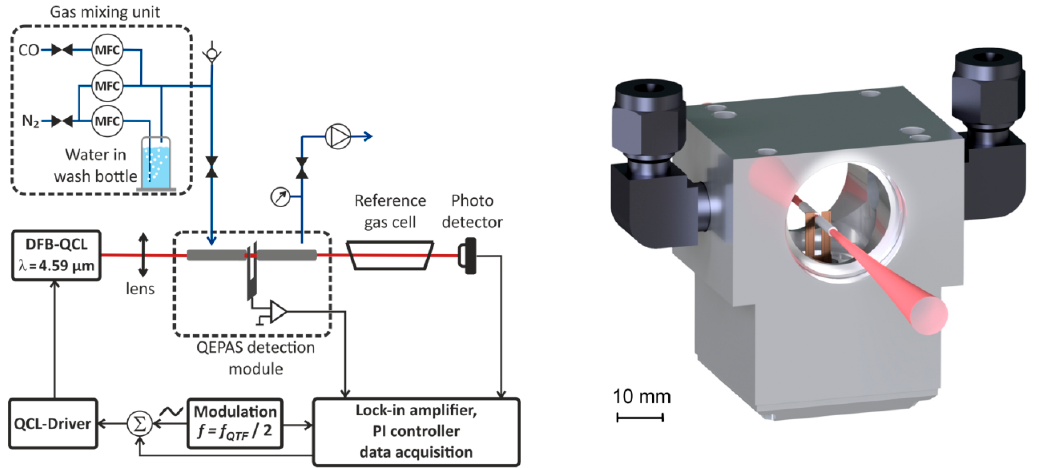
Figure 1. ( Left ) Schematic of the experimental setup for humidity dependent 2 f -WM-QEPAS measurements of CO in humidified N 2 , see text. MFC: mass flow controller, DFB-QCL: Distributed feedback quantum cascade laser. ( Right ) Rendered image of the acoustic detection module and custom tuning fork.